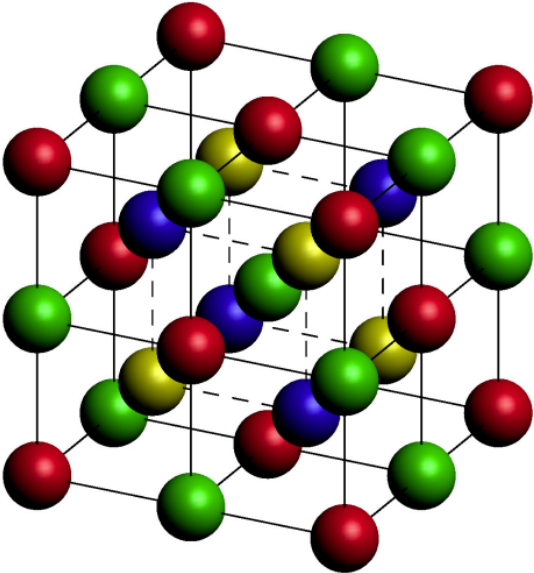
Figure 1. Crystallographic structure of X 2 YZ Heusler alloys is shown in this diagram. Blue (A sites), green (B sites), yellow (C sites), and red (D sites).